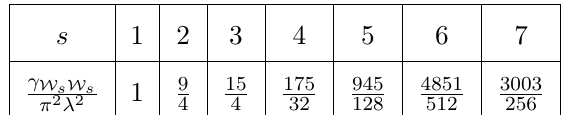
for the first few values of s s W s